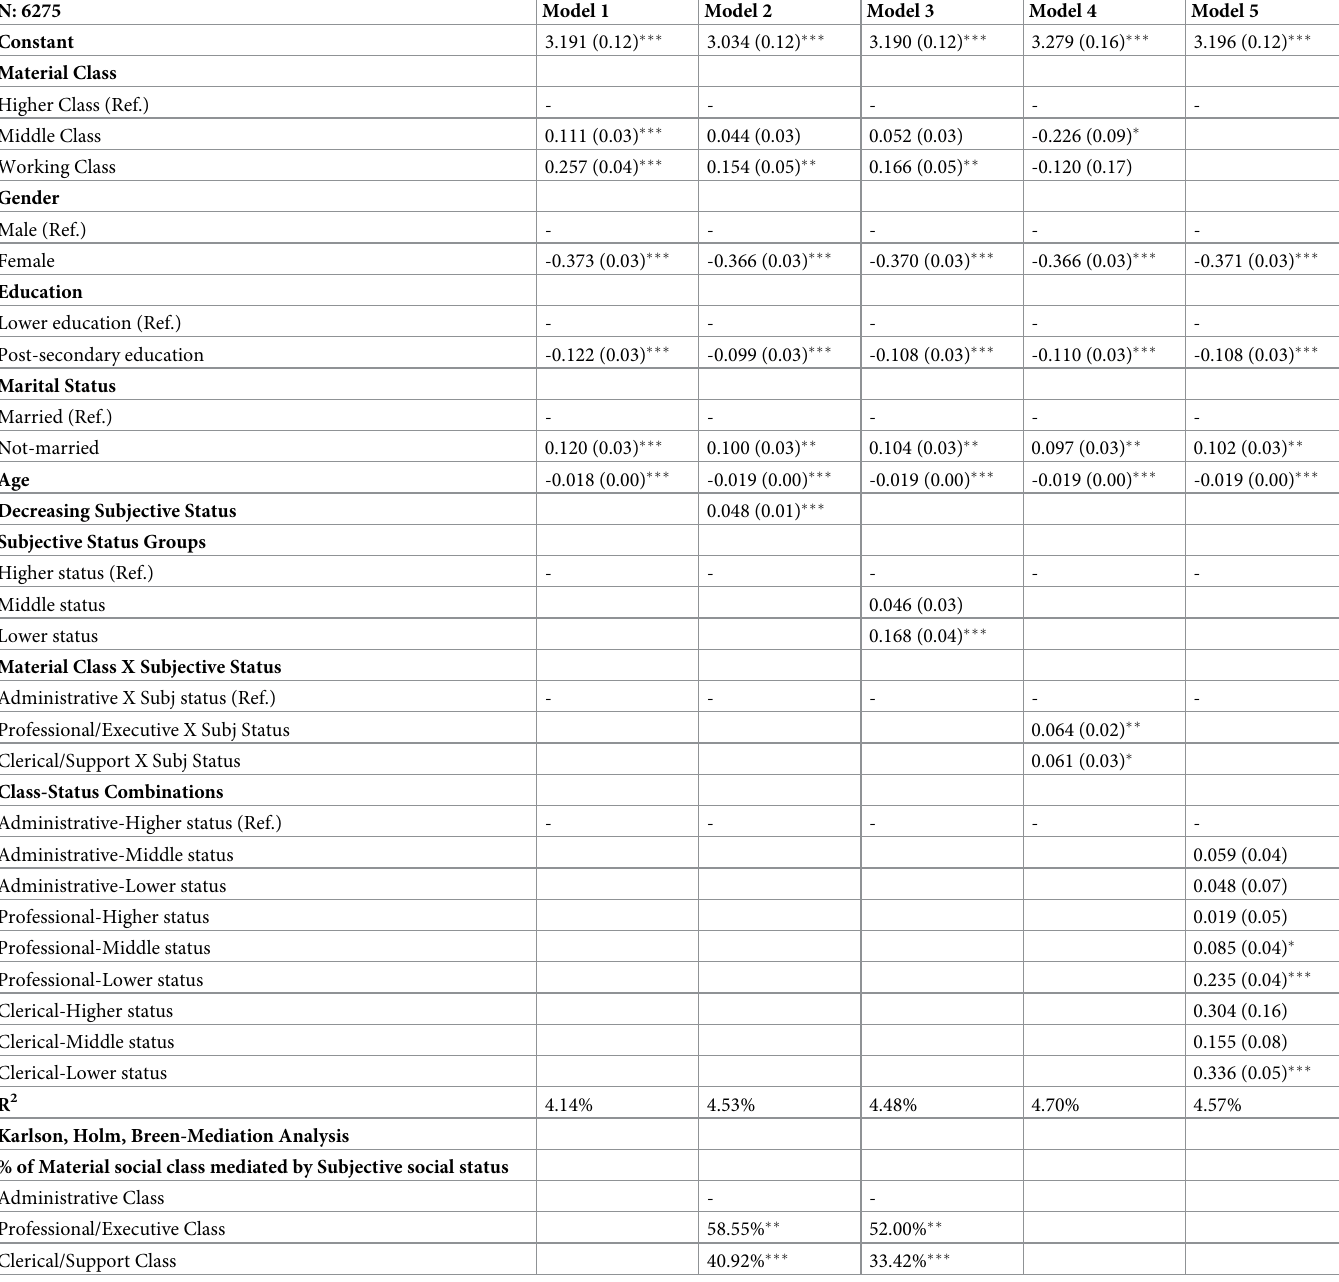
Table 2. Material class and subjective social status regressed on unhealthy behaviors including control